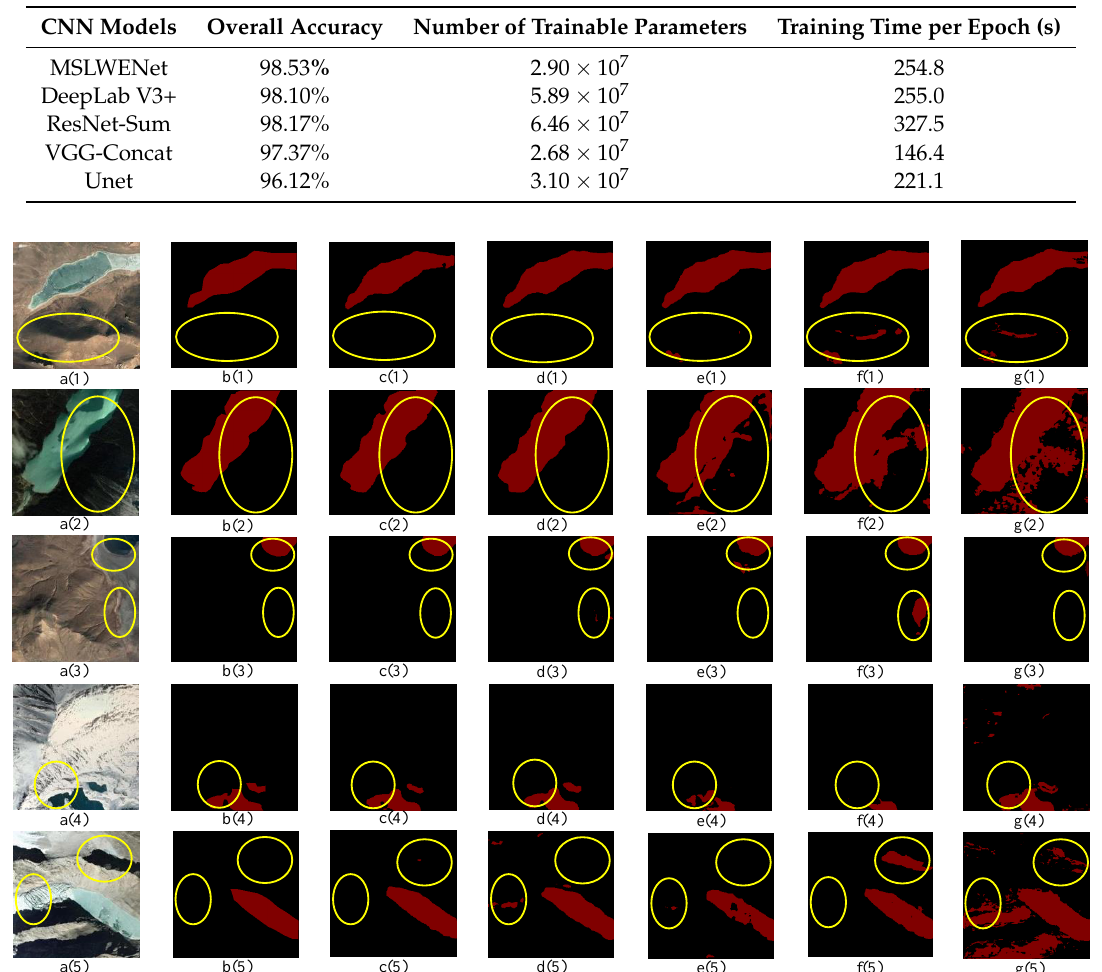
Table 6. Performance comparison of different encoders and decoders in Figure 10.